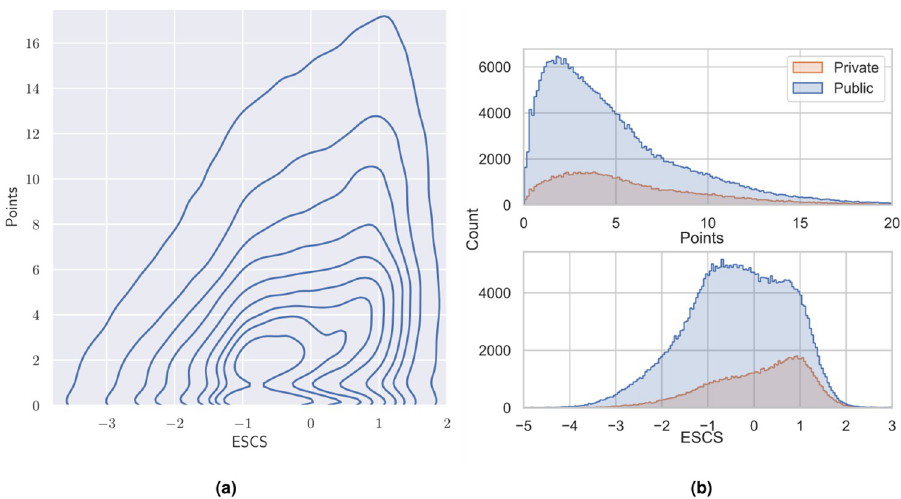
Fig 1. The distribution (number of students, as isolines) of student results (Points) over economic, social and cultural status (ESCS) is skewed so that highly performing students tend to be more privileged (a). Fig 1(b) shows that private schools tend to have somewhat better results than public schools (top), and that students at private schools are more privileged (bottom). The 57464 students with zero points (visible in (a)) have been omitted in the top figure to better display the distribution of the other students.